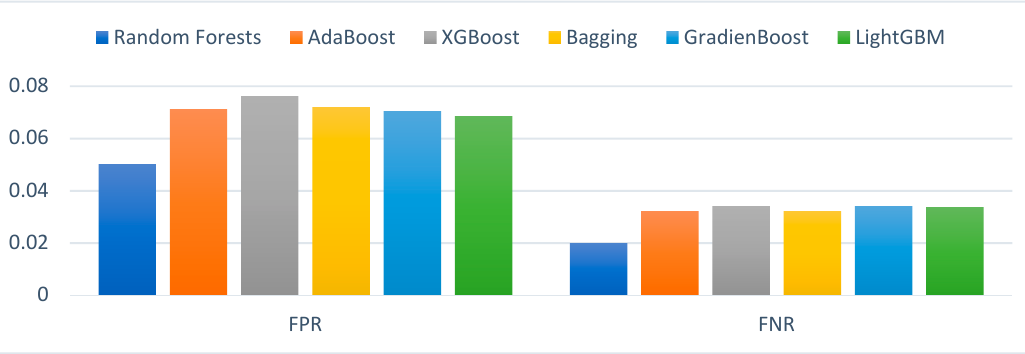
Figure 4. Comparisons of the FPR and FNR of ensemble methods for Dataset 3 .